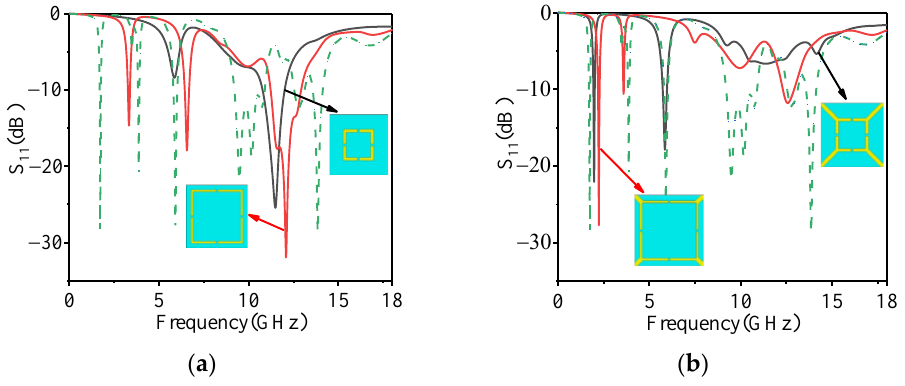
Figure 2. The absorbing effect of each structure acting independently; ( a ) is S 1 and S 2 , and ( b ) is S 3 and S 4 .